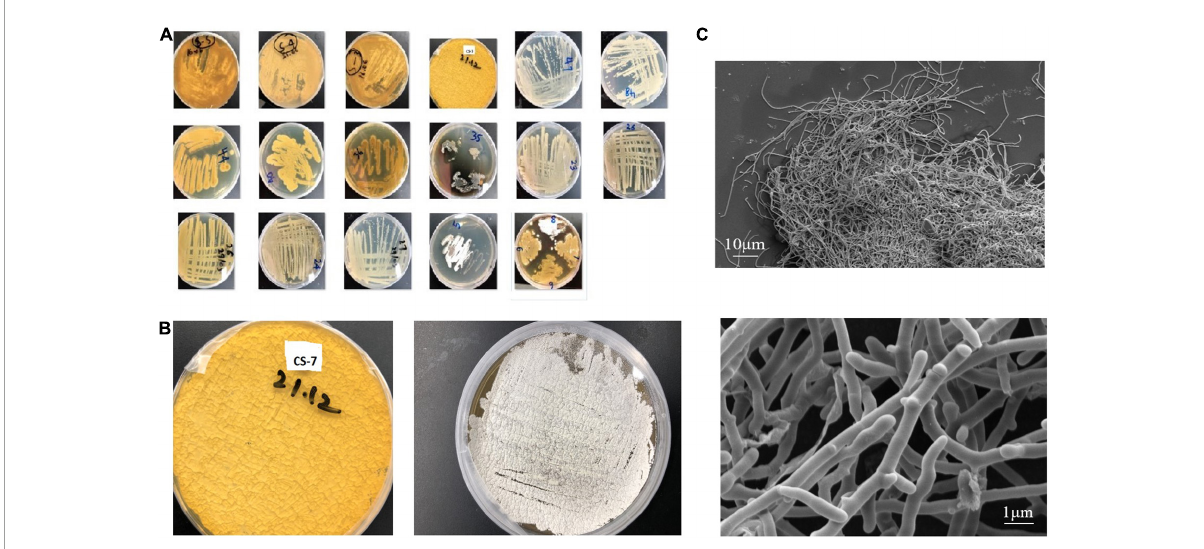
FIGURE1 Isolation and morphological observation of Streptomyces spp. (A) Isolated samples from mountain soils in China cultivated on International Streptomyces Project agar number 2 (ISP2) media at 28 ◦ C for 15 days (plate’s number indicates the soil site and letter indicates a phenotype).